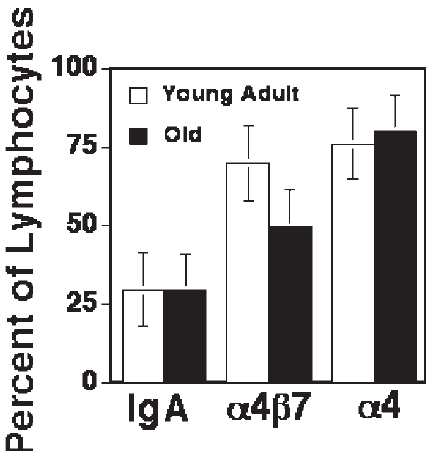
FIGURE 3 Flow cytometric analysis of the expression of the homing integrin a 4 b 7, the integrin monomer a 4 and IgA on the surface of peripheral blood mononucelar cells isolated from young and old rats. The relative percentages of cells expressing either IgA or a 4 remain unchanged as a function of donor age. However, the expression of the homing molecule a 4 b 7 declines by approximately 30% in cells from old rats (*) in comparison to those isolated from young animals ( P , 0.01). Each bar represents the mean ^ SD for 12 young or 7–8 old rats.